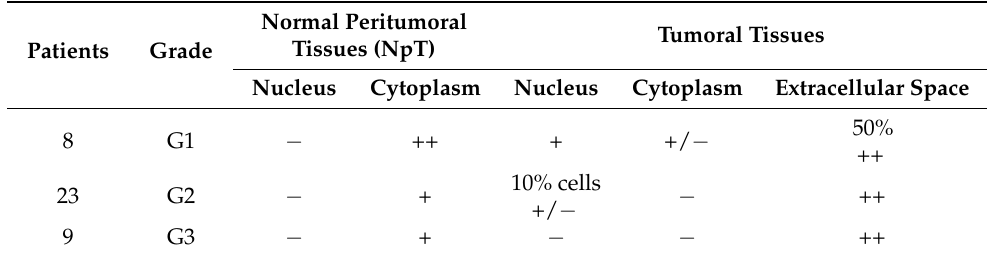
Figure 2. Hematoxylin/Eosin staining and LOX-1 immunohistochemistry of healthy autopsy kidney tissue. ( A – C ) Ema- toxylin/Eosin staining, ( B – D ) LOX-1 immunohistochemistry, ( A , B ) magnification 20×, ( C , D ) magnification 40×. Table 2. Distribution of LOX-1 in tumor and healthy counterpart of different grade and